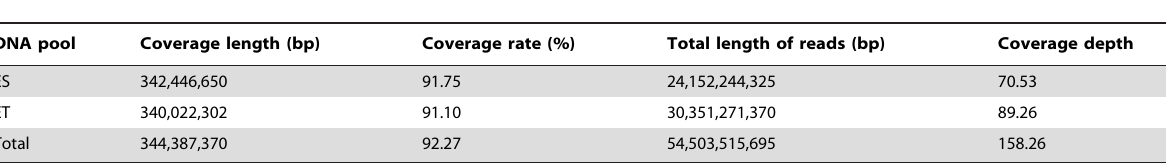
Table 2. Coverage of the rice genome by the uniquely mapped reads.